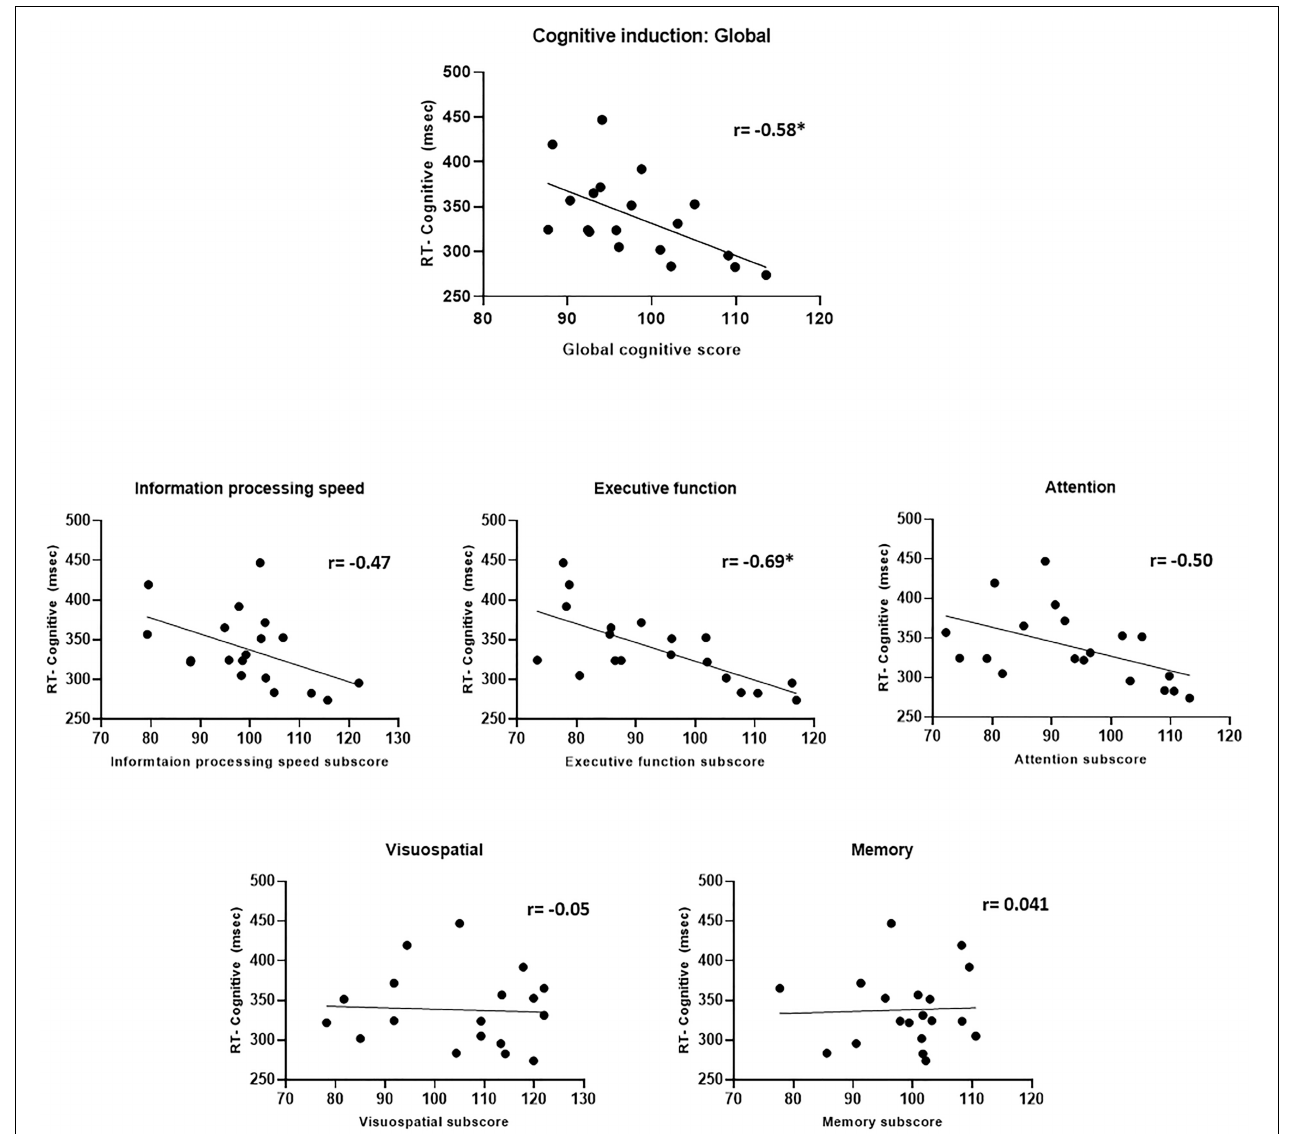
FIGURE 11 | Cognitive induction scores and CPT performance. Upper panel: Global cognitive score and CPT response time. Middle and lower panel: Cognitive induction battery sub-scores and CPT response time. Better cognitive induction performance in ADHD-related domains (information processing, executive function, and attention) was related to better CPT performance, while performance in less ADHD-related domains (visuospatial and memory) was not related to CPT performance (* p < 0.05,